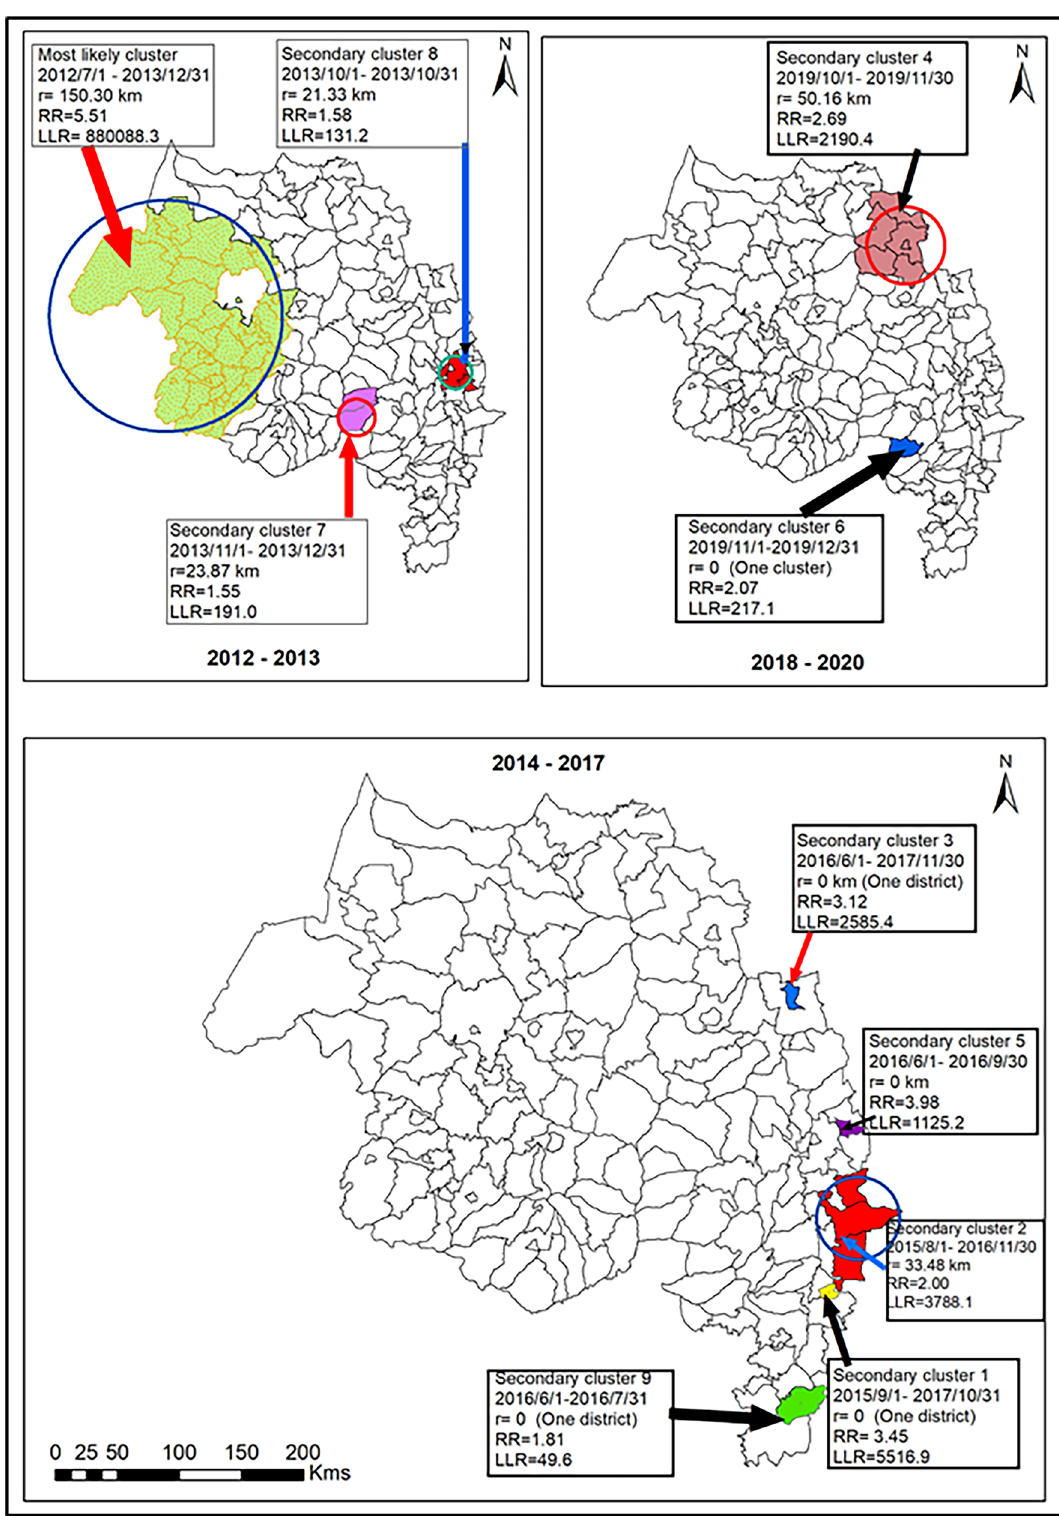
Figure 4. Spatiotemporal clusters of malaria cases at district level without adjusting to the altitude and LLINS covariates in northwest Ethiopia,